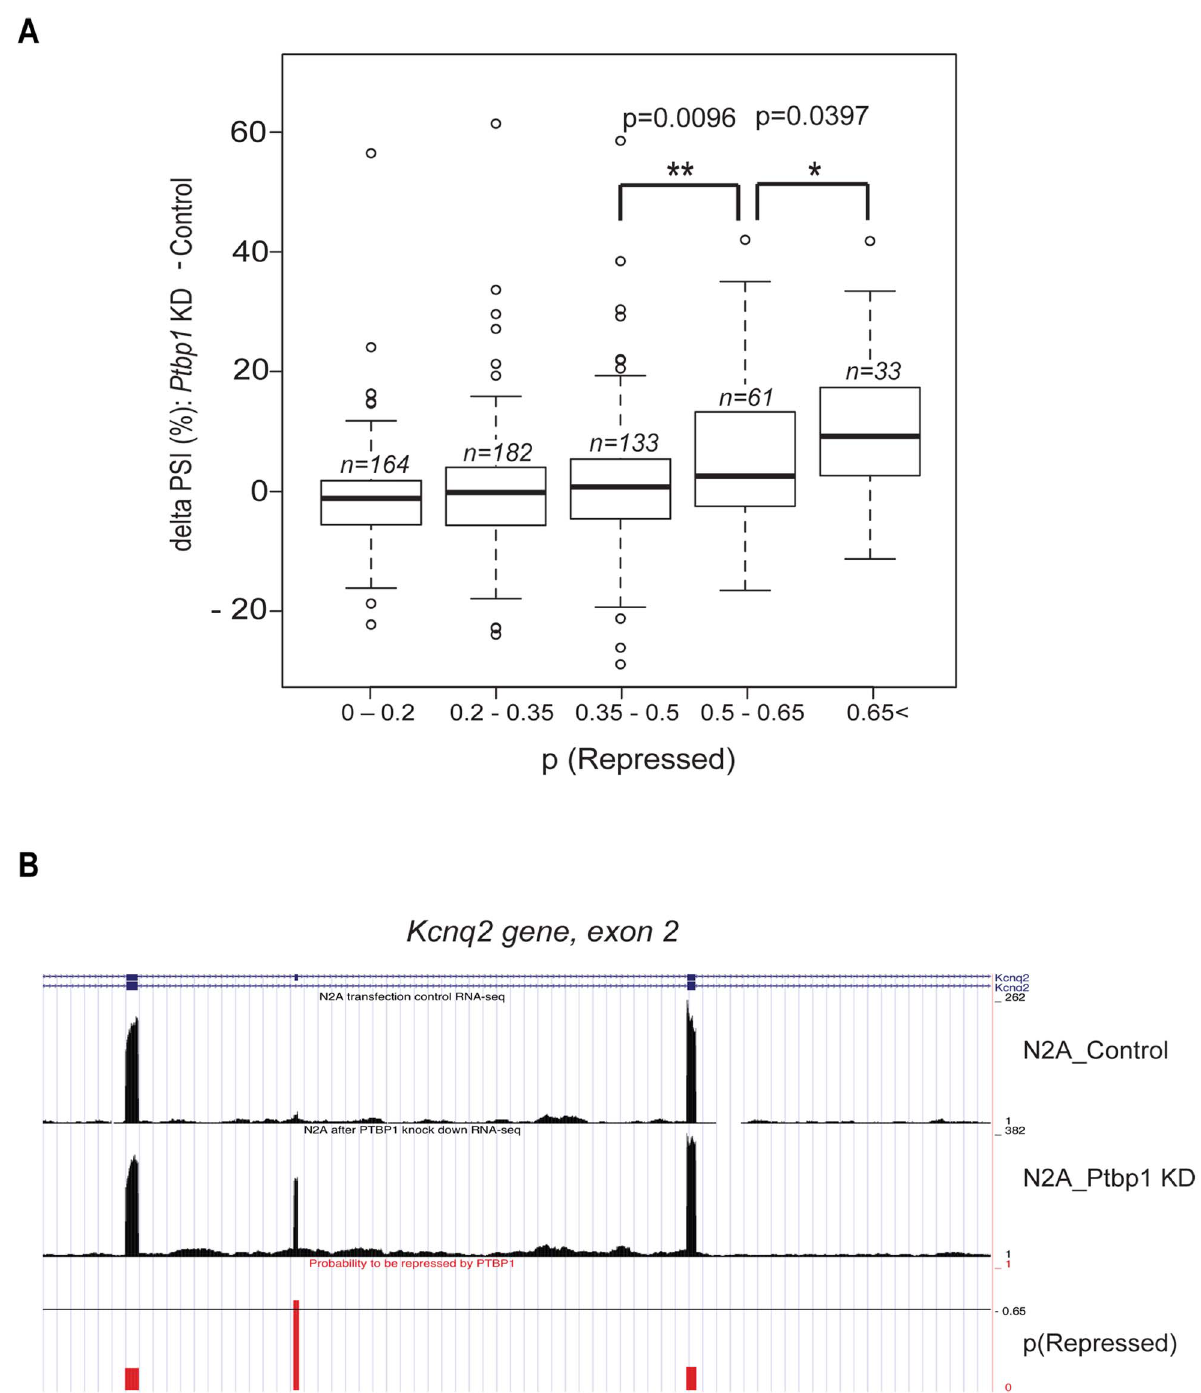
Figure 6. Large-scale validation of novel PTBP1-repressed exons by RNA-seq. A . Validation of the PTBP1 splicing model using RNA-seq. After Ptbp1 knockdown, we performed RNA-seq experiments and estimated changes in PSI (Percent of Spliced In) for 573 cassette exons. The graph shows average delta PSI values for exons, grouped by their probabilities to be repressed by PTBP1. The number of exons in the corresponding probability bin is given by n. P-values were calculated from one-tailed Student’s t-test. B . A genome browser screenshot of a novel PTBP1-regulated exon: exon 2 of the Kcnq2 gene. For whole internal mouse exons, we created custom genome browser tracks to visualize the PTBP1 splicing model and mapped RNA seq reads.